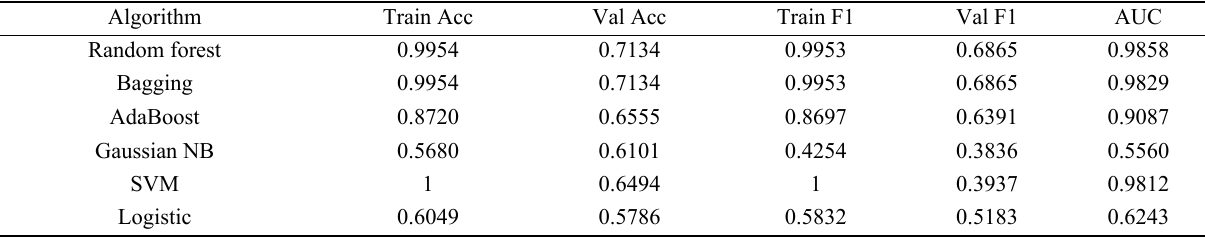
Table 13 Algorithm performance of bagging, boosting, Gaussian NB, and SVM (24-split subsample with 337 control variables).